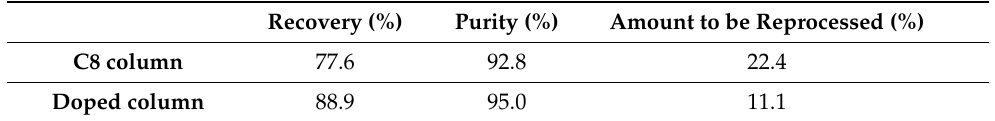
Table 1. Performance parameters obtained with the two columns when pooling the target peaks with the exception of their tails, and amount of peptide that must be reprocessed in both cases because of liraglutide under the discarded